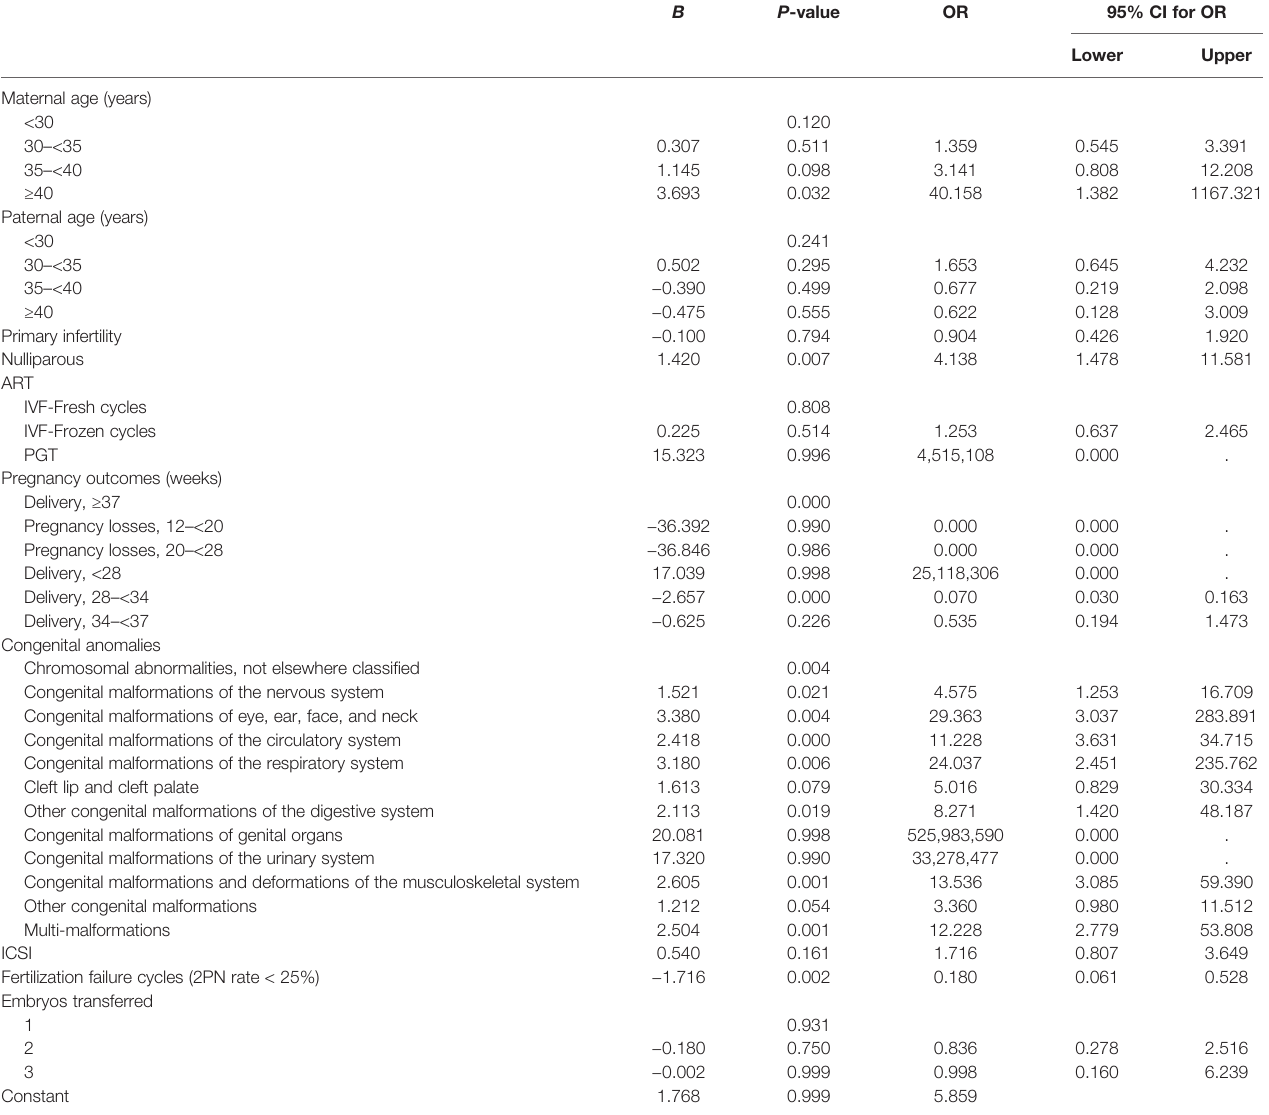
TABLE 5 | Logistic regression of the relatively positive prognosis rate in IVF cycles.